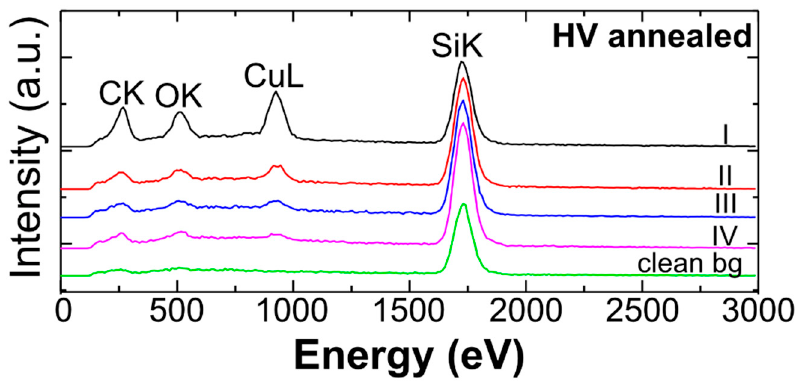
Figure 5. EDX spectra of non-irradiated areas in proximity to irradiation fields I–IV (HV annealed sample). Green spectrum: clean SiO 2 (nat.)/Si surface was measured outside the condensate area for comparison.